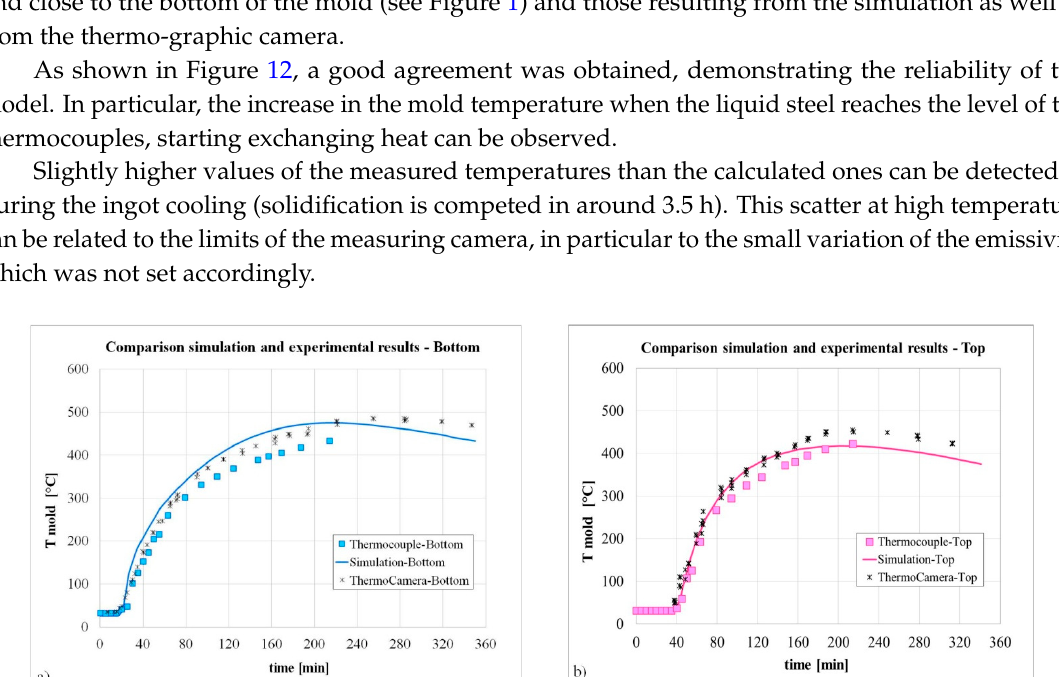
Figure 12. Comparison between simulation and experimental measurements for the bottom ( a ) and top ( b ) thermocouples.